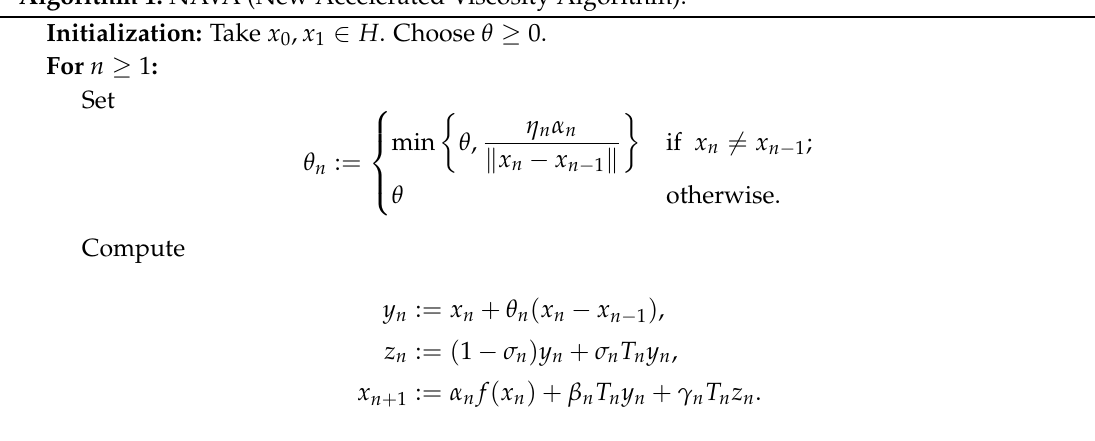
Algorithm 1: NAVA (New Accelerated Viscosity